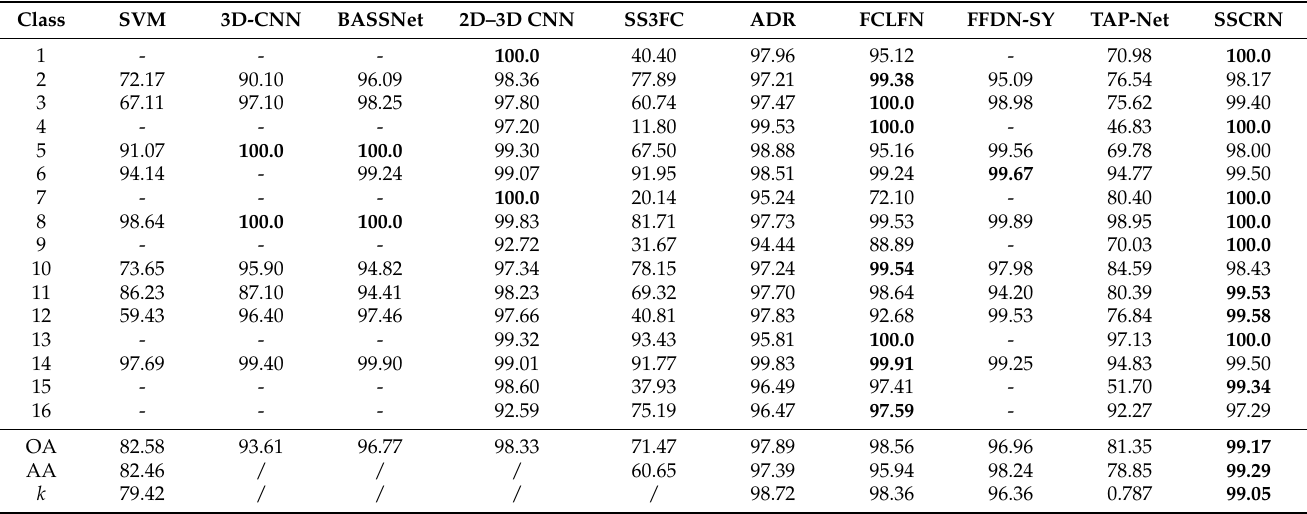
Table 7. Classification results (%) of different methods on the IP dataset. Bold indicates the best accuracy.